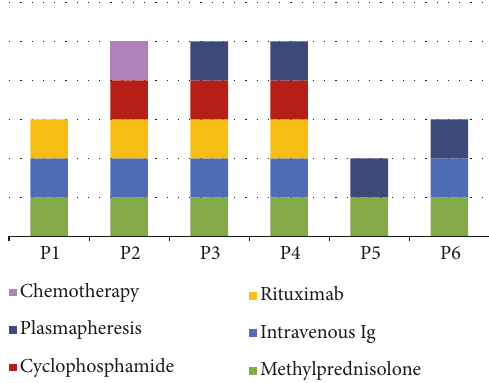
Figure 3: Treatment grouped by patient . P1, P3, P4, and P5 received methylprednisolone (1 g IV daily) during 5 days; P2 and P6 received methylprednisolone according their weight (1mg/kg) also during 5 days. IVIG was administered in five cases at immunomodulatory doses (400-800mg/kg/day). P2 and P3 needed cyclophosphamide (750 mg/m 2 IV) every three weeks during 4 cycles; P4 received cyclophosphamide (750 mg/m 2 IV) 2 cycles with 6 weeks